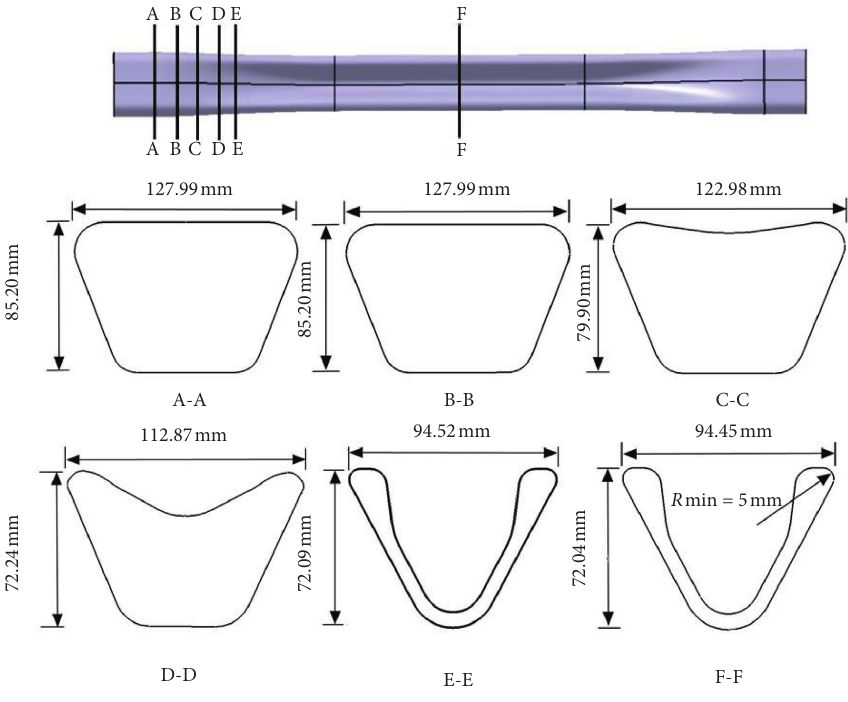
Figure 2: Section shape diagram of torsion beam. Table 1: Typical section perimeter table. Cross section